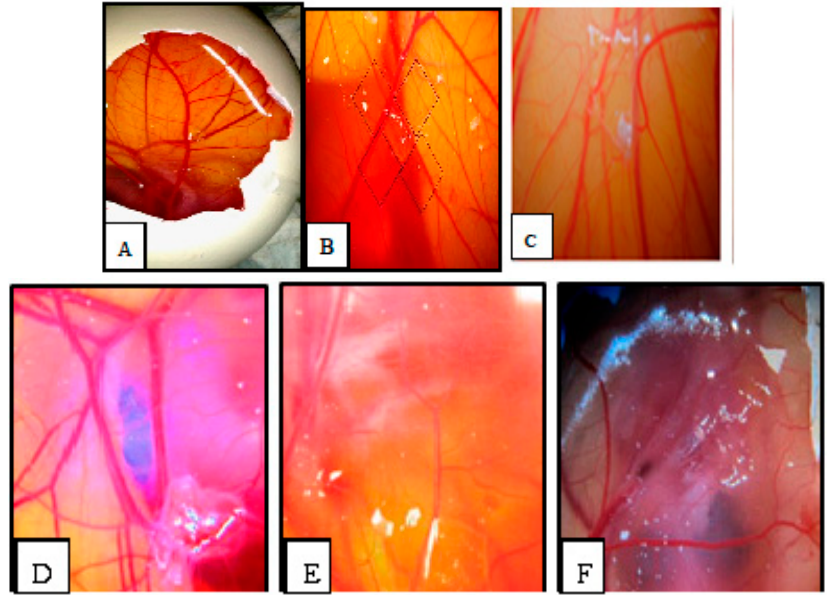
Figure 7. ( A ) Image of CAM with gelatin sponge; and ( B ) Square which counting was done there (right); ( C ) Control, ( D ) 12.5; ( E ) 25 and ( F ) 50 µg/mL concentrations of PVLH-EAE.